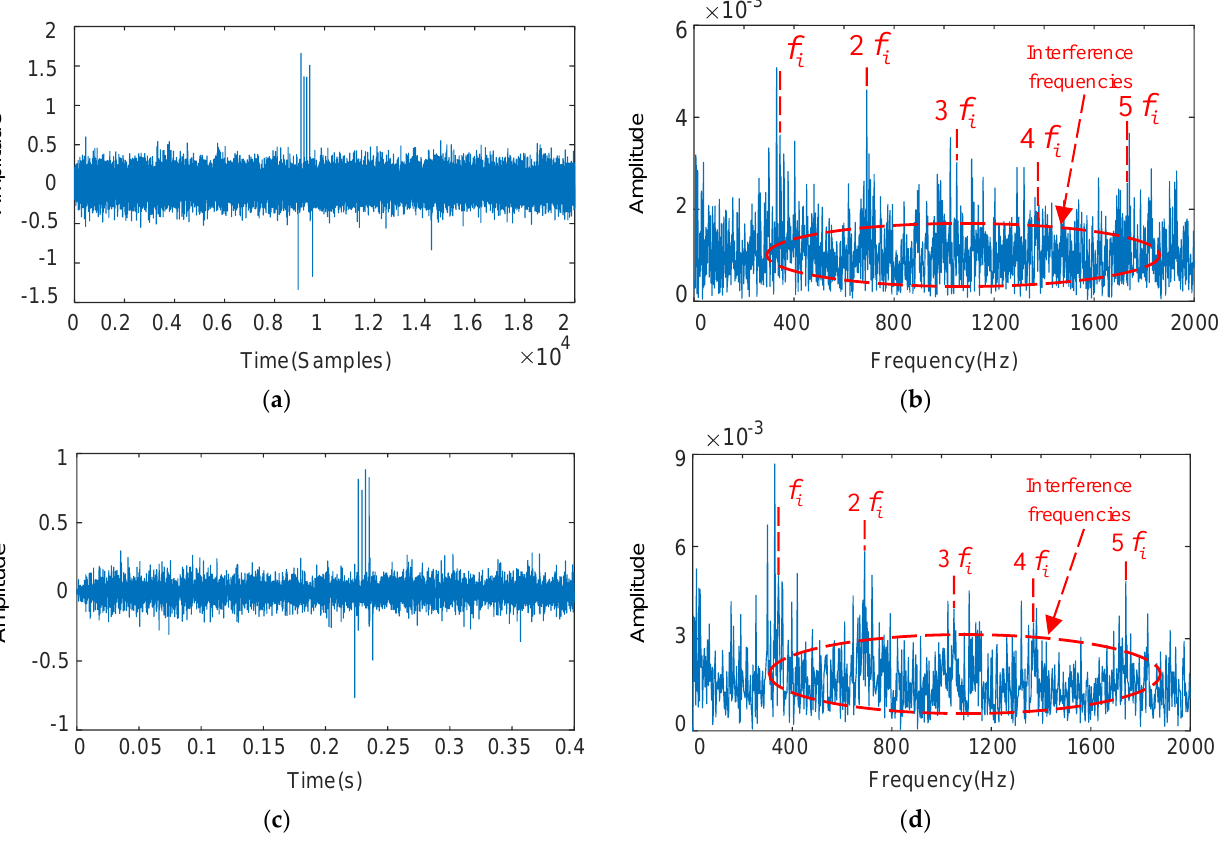
Figure 14. The bearing inner ring deconvolution results by MCKD: the filtered time domain waveform and their spectrum ( a , b ); results obtained by MCKD + RSSD: time domain waveforms and their frequency spectrum ( c , d ).